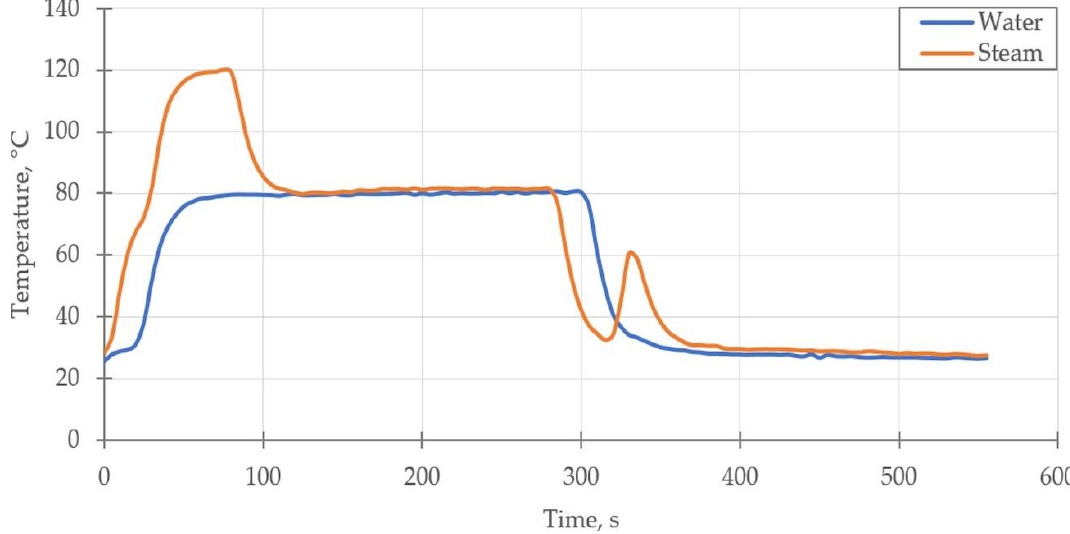
Figure 3. Temperature of the medium inlet (T5) to the adsorption chiller bed during desorption.